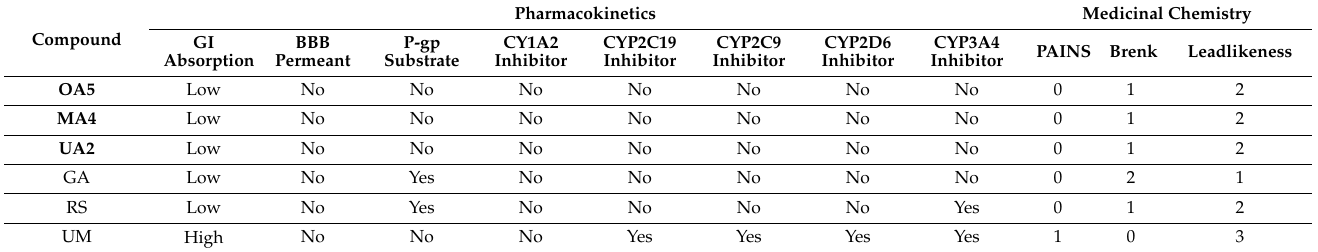
Table 3. Pharmacokinetic and medicinal chemistry properties.